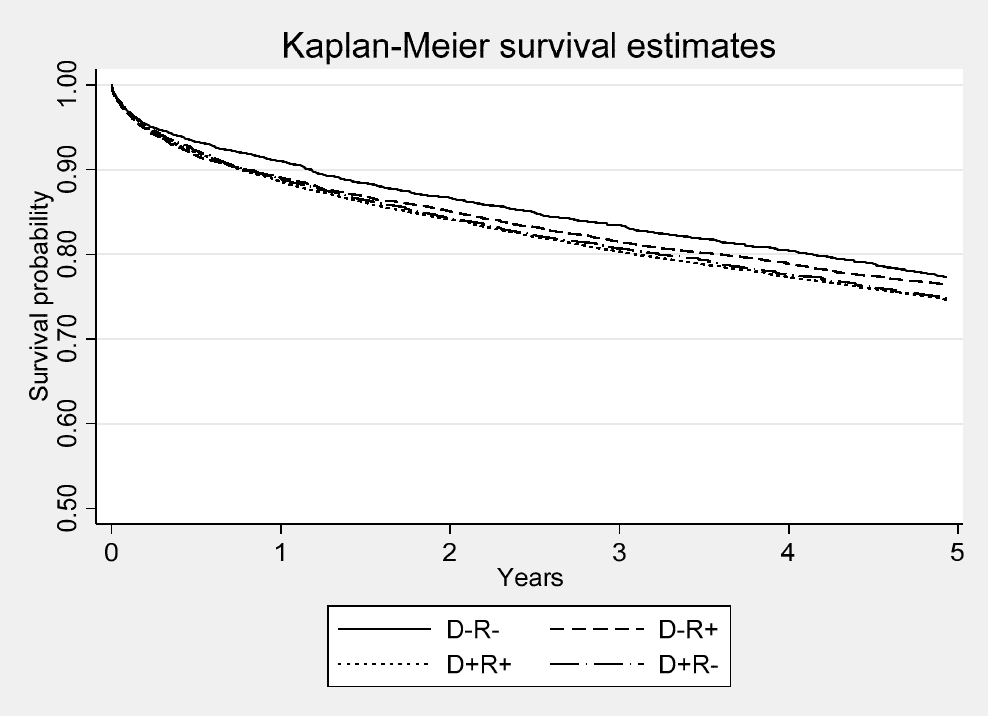
Figure 2. Kaplan-Meier survival functions for each of four donor and recipient CMV serostatus groups. D = donor; R = recipient. All-cause mortality was higher in the CMV seropositive recipient or donor groups when compared to D-R- group. The risk of death was 1.07 (CI 1.03–11) for D-R+, 1.15 (CI 1.11–1.19) for D+R+ and 1.14 (CI 1.10–1.18) for D+R. The four survival curves were significantly different ( p < 0.001). Table 6. Association of functional status at last follow-up with infection as a cause-of-death in pa- tients who died. Patients with functional impairment were significantly more likely to have infec- tions as cause-of-death compared to those with normal functional status.